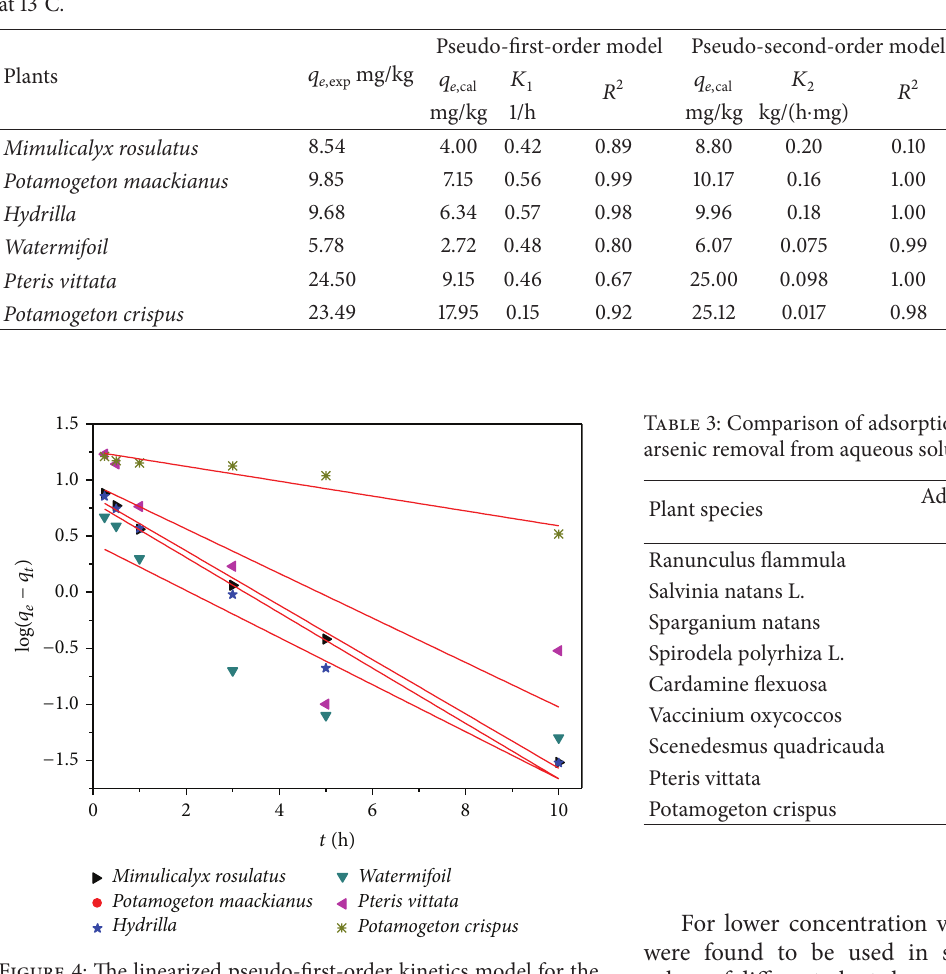
Figure 4: The linearized pseudo-first-order kinetics model for the removal of As (III) ( 𝑇 = 13 ∘ C, initial As (III) concentration = 1.000 mg/L).